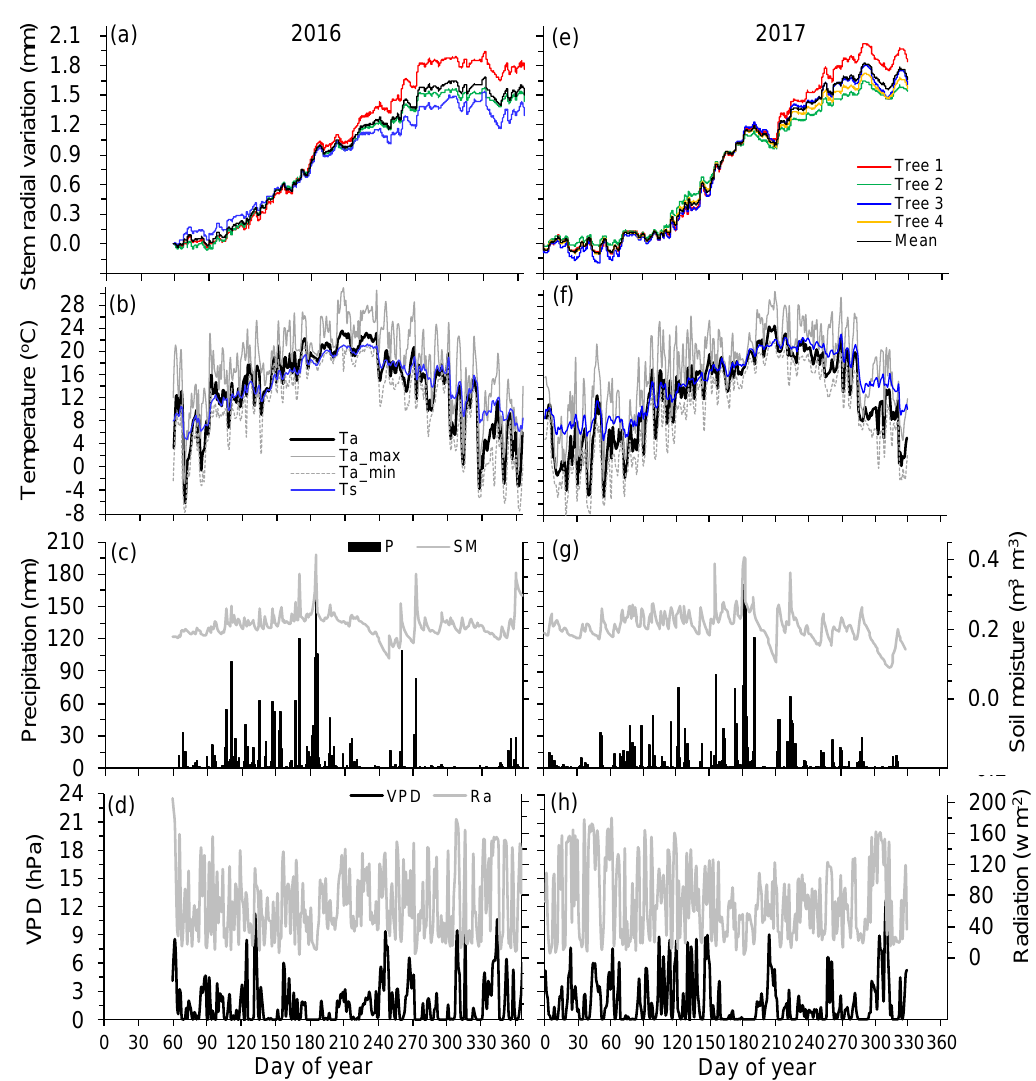
Figure 3. Annual courses of hourly radial records of monitored trees ( a , e ), air and soil temperatures (Ta, mean air temperature; Ta_max, maximum air temperature; Ta_min, minimum air temperature; Ts, mean soil temperature) ( b , f ), precipitation (P) and soil moisture (SM) ( c , g ), vapor pressure deficit (VPD) and solar radiation (Ra) ( d , h ) during 2016 and 2017.